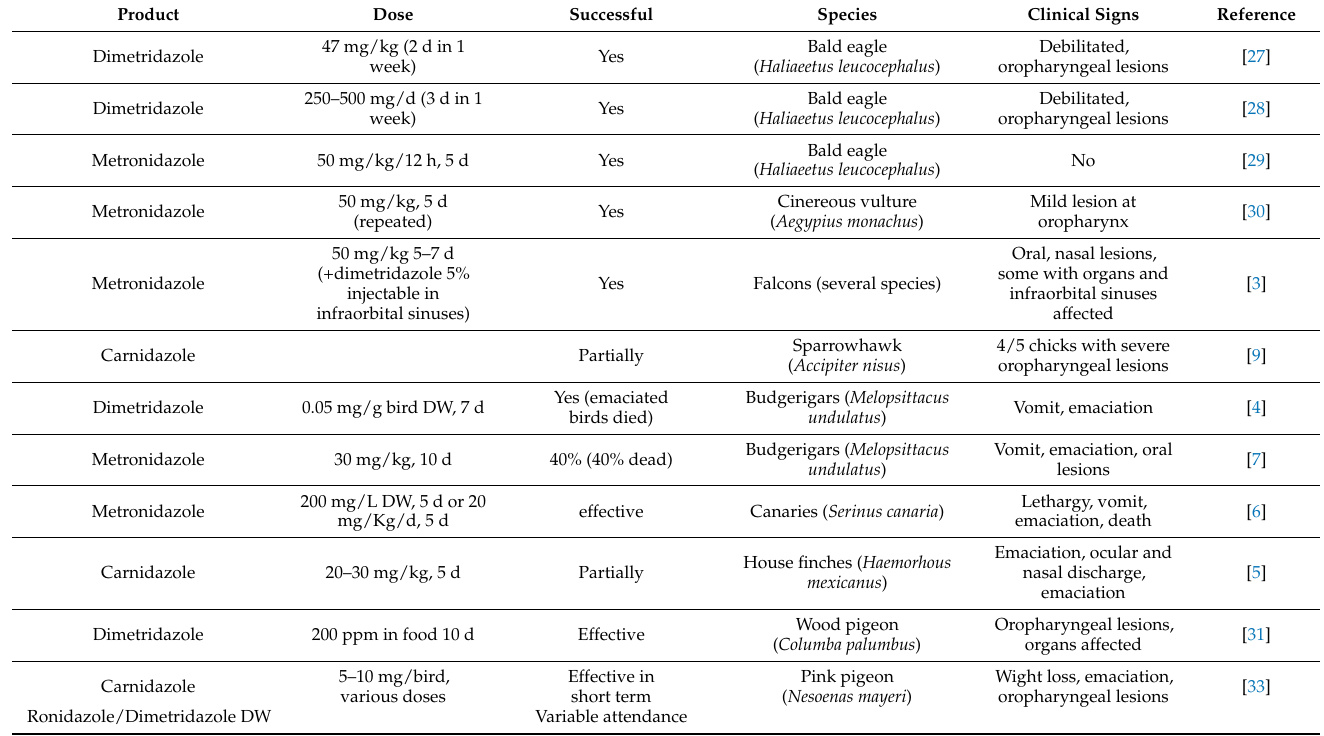
Table 2. Treatment employed against avian oropharyngeal trichomonosis in birds other than domestic pigeons. Products, doses and successful rates are indicated. Only effective drugs (efficacy higher than 80%) are included in the